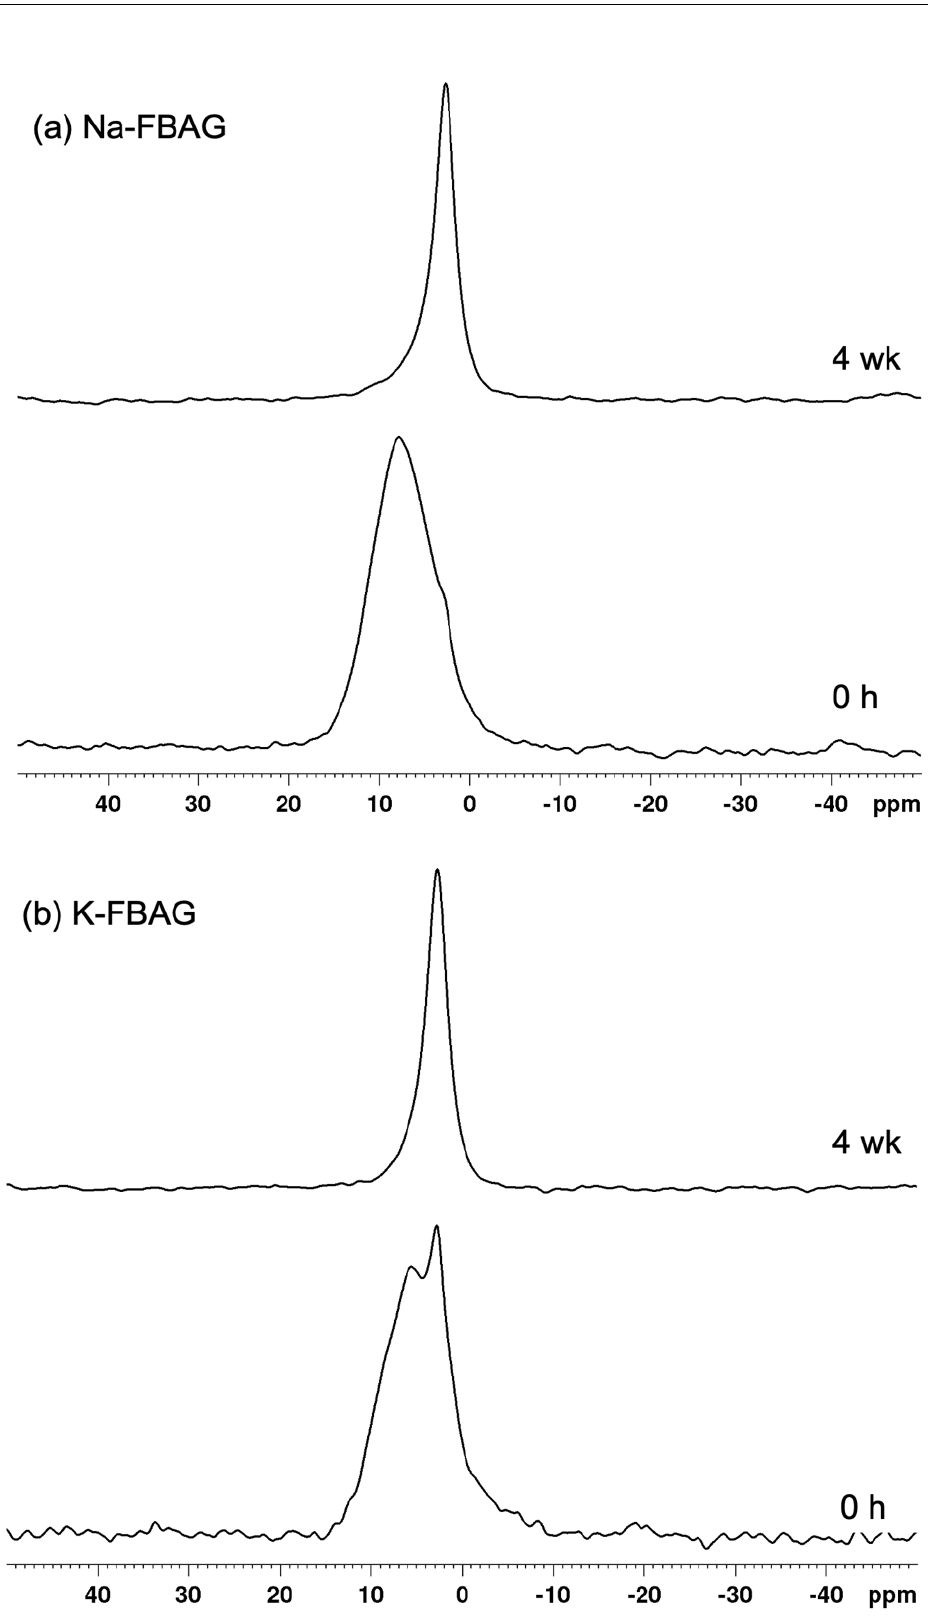
Figure 7. 31 P MAS-NMR spectra for ( a ) Na-FBAG and ( b ) K-FBAG.